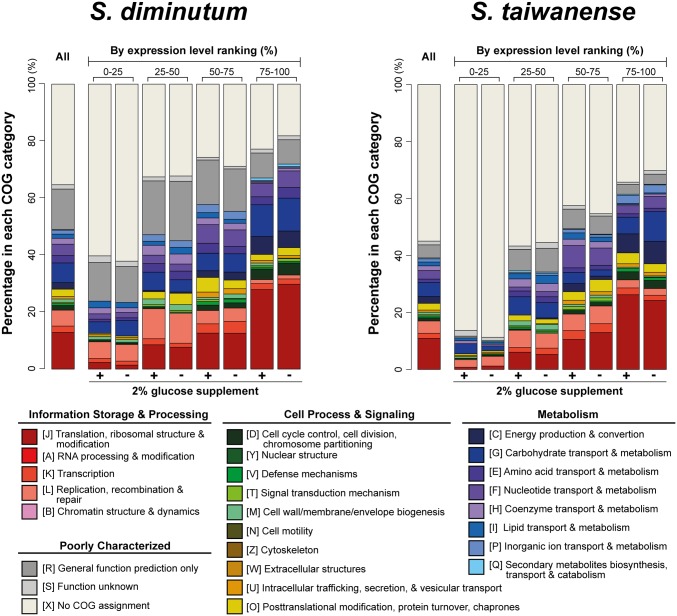
—Functional category distribution of protein-coding genes. The functional categories are assigned based on the COG database. In addition to the overview (“All”), the protein-coding genes in each genome are divided into four groups according to their percentile ranking of expression levels.